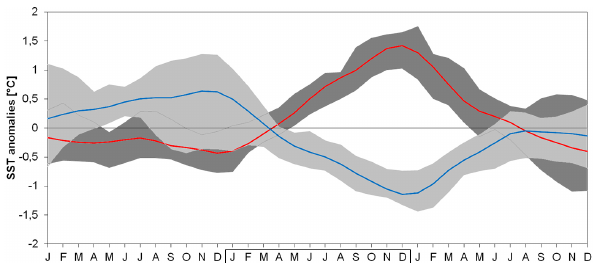
Figure 2. Composite of monthly SST anomalies for El Niño (red line) and La Niña (blue line) during the 1961–2008 period. The 36 month composite starts at January ( − ) and continues until Decem- ber ( + ) . Dark (light) grey bands around the composite anomalies represent the inter-quartile interval for El Niño (La